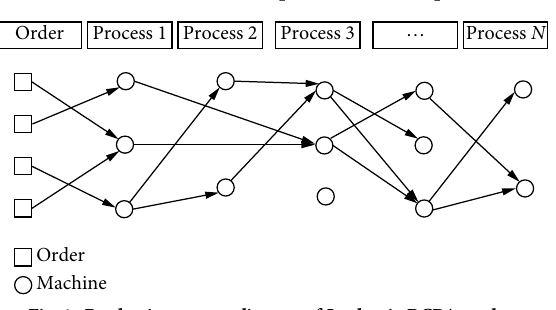
Fig. 4 Production process diagram of I orders in RCPA mode.